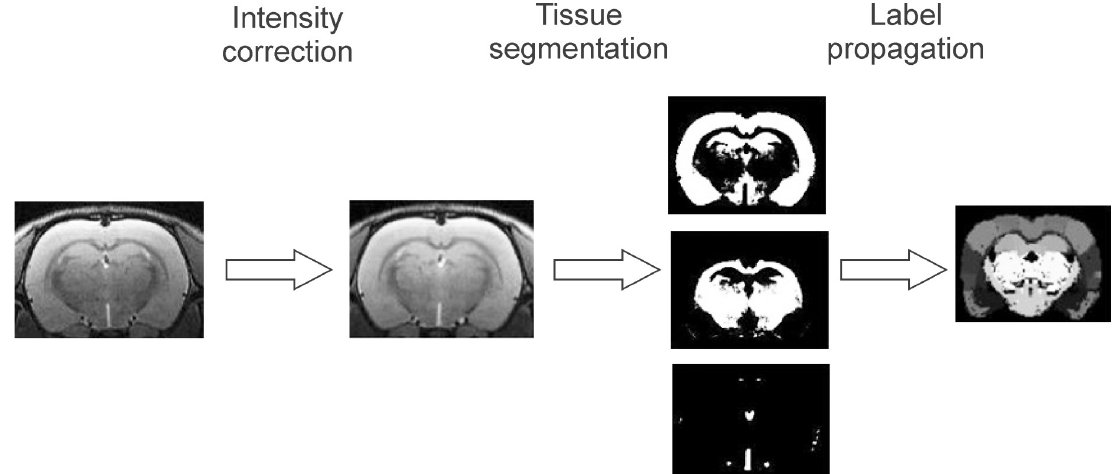
Fig 1. A simplified image processing pipeline. High resolution T2-weighted images were intensity corrected and automatically segmented for white matter, grey matter and cerebrospinal fluid. In next step the images were transformed to brain template which allowed applying labels (ie. identification of brain structures defined in brain atlas). Back-transformation to original dimension allowed identification of brain structures in the original images and calculation of volumes of the pre-defined structures.